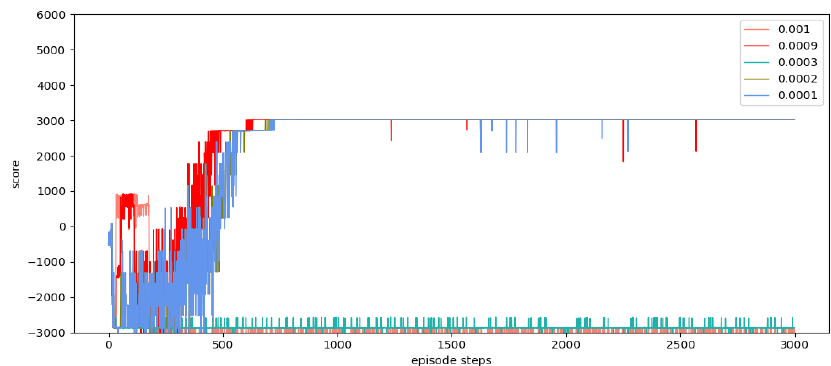
Figure 5. Training result of TD3 algorithm model in environment 1.